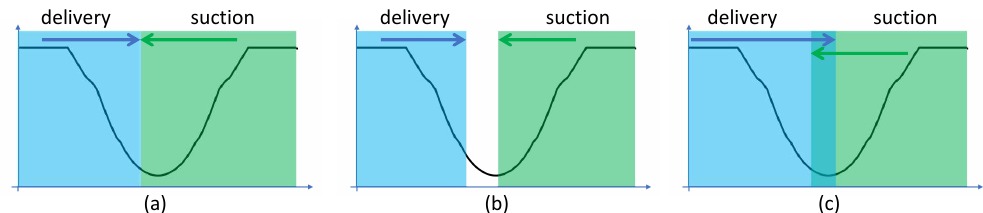
Figure 11. Three porting conditions based on volume curve: ( a ) connected porting ( b ) open porting ( c ) overlapping porting.